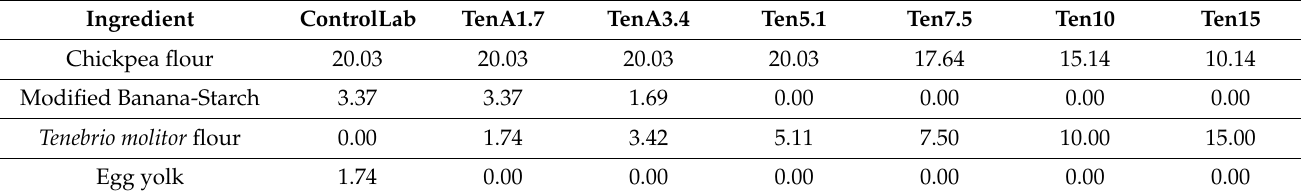
Table 1. Content of chickpea flour, modified banana-starch, Tenebrio molitor and egg yolk of the different